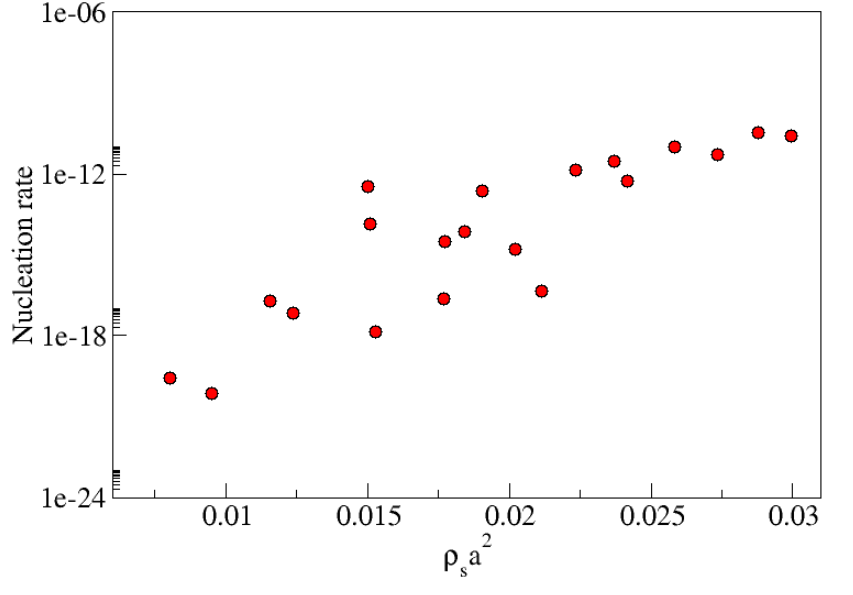
= a 2 / D ) as function of the surface density ρ s . Each symbol Figure 6. Nucleation rate (in units of ν − 1 0 corresponds to the normalized amount of molecules absorbed on surfaces characterized by different roughness and correlation